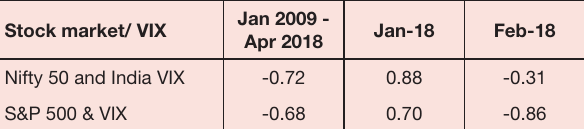
Table 1: correlation coefficient between Stock